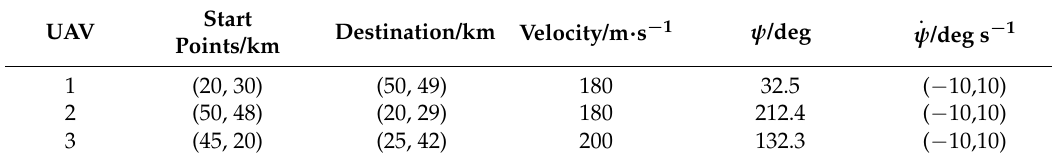
Table 1. Initial conditions and parameter values for Simulation 1.